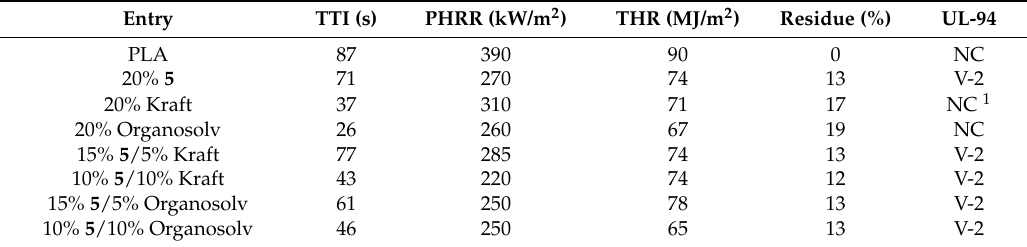
Table 5. Cone calorimetry data and UL-94 results for PLA– 5 –lignin composites.